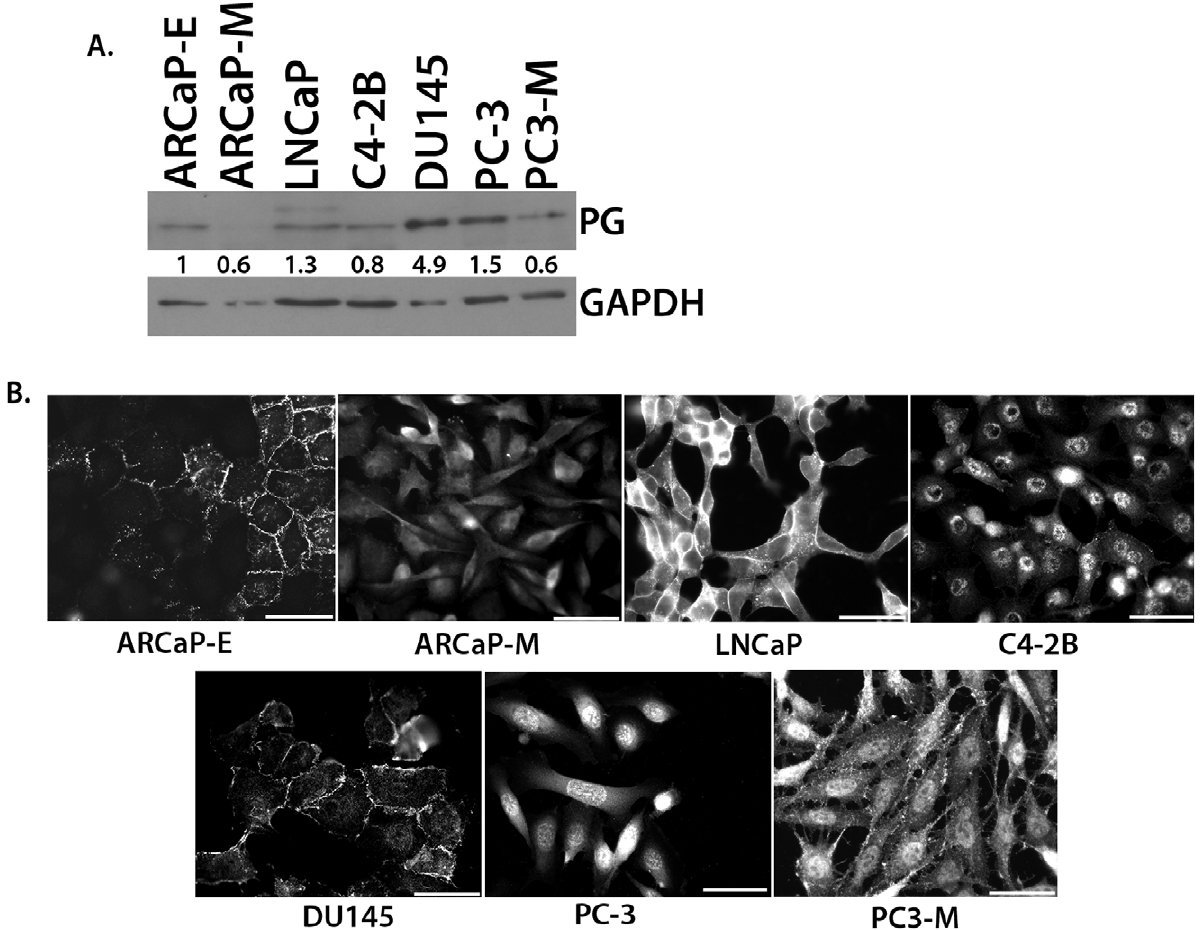
Figure 2. Expression levels and localization of PG in prostate cancer cell lines. A. Prostate cancer cell lines were lysed and subjected to SDS- PAGE, followed by immunoblotting with antibodies against PG and GAPDH. PG levels were determined by normalizing to GAPDH levels for each cell line using Image J. The immunoblot shows that the expression of PG in prostate cancer cell lines inversely correlates with the degree of aggressiveness of the cell line. B. Prostate cancer cell lines were plated onto coverslips and allowed to attach and spread. Immunofluorescence was performed using antibodies against PG to demonstrate the localization of PG in ARCaP E , ARCaP M , LNCaP, C4-2B, DU145, PC-3, and PC3-M cell lines. The immunofluorescence shows weaker staining and a loss of cell-cell border localization of PG in the more aggressive cell lines (ARCaP M , C4-2B, and PC3-M). Representatives of at least three independent immunoblots are shown, with numbers representing GAPDH normalized PG protein levels for the blot shown. All the PG protein levels were normalized to ARCaP E levels within each blot. The average level and standard deviation of PG protein levels in panel A is as follows: ARCaP E 1.0, ARCaP M 0.3 + / 2 0.2, LNCaP 1.5 + / 2 0.5, C4-2B 0.5 + / 2 0.2, DU145 3.4 + / 2 1.2, PC-3 1.0 + / 2 0.4, PC3-M 0.5 + / 2 0.2.